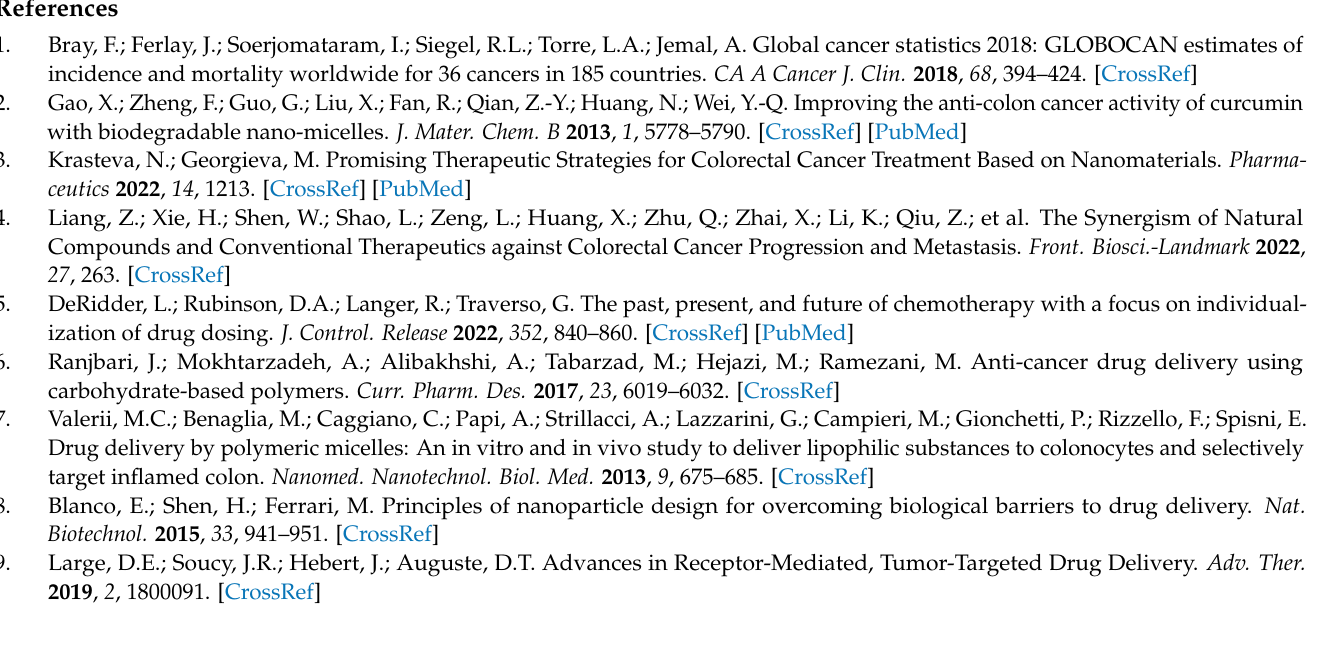
Figure S2. 1H-NMR spectra (500 MHz) of Chitosan in D2O with acetic-D (1), N -benzyl chitosan (NBCh) in DMSO-d6 (2) and N -benzyl- N , O -succinyl chitosan (NBSCh) in DMSO-d6 (3); Figure S3. Graph for determination of CMC value of NBSCh micelle using Pyrene as a fluorescence